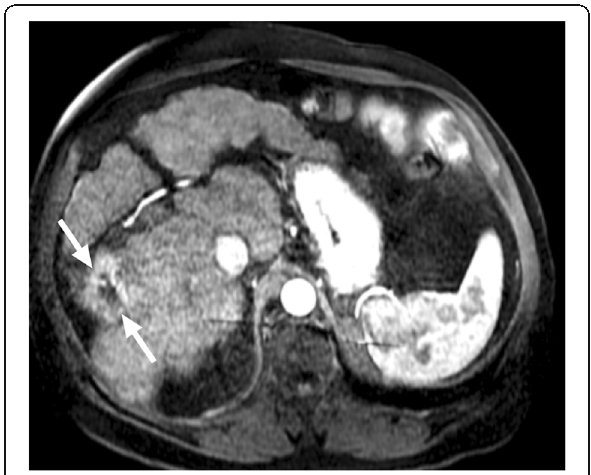
and luminal stenosis are typical imaging findings. Focal